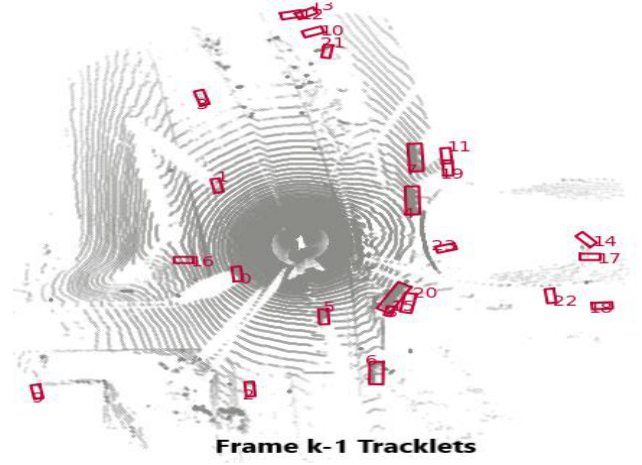
Figure 2. Vehicle bounding box detectors.